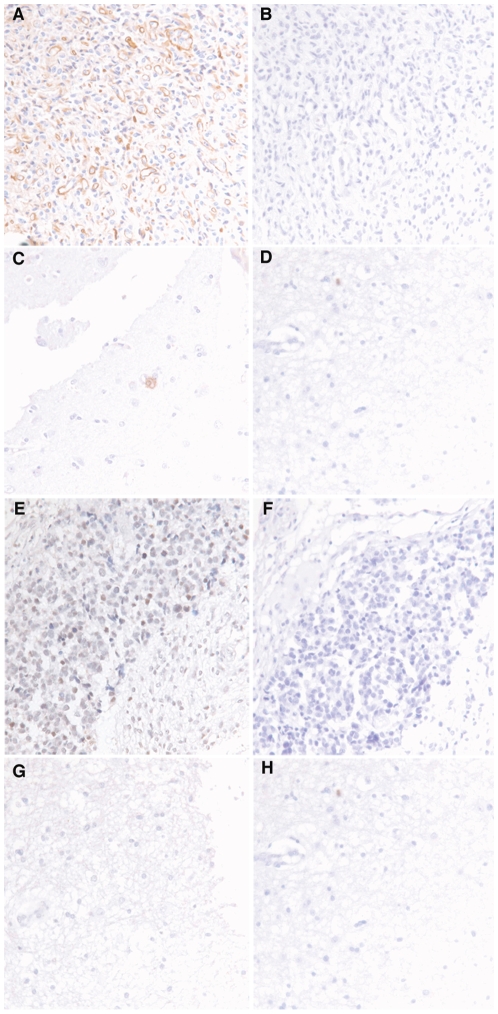
Examples of IHC staining of GBM and normal brain tissue samples.A: TGFBI (GENE ID:7045) antibody staining of GBM tissue; B: IgG staining of GBM tissue; C: TGFBI (GENE ID:7045) antibody staining of normal brain tissue; D: IgG staining of normal brain tissue. E: SOX4 antibody staining of GBM tissue; F: IgG staining of GBM tissue; G: SOX4 antibody staining of normal brain tissue; H: IgG staining of normal brain tissue. Please see Table 1 for data summary of the entire tissue array.